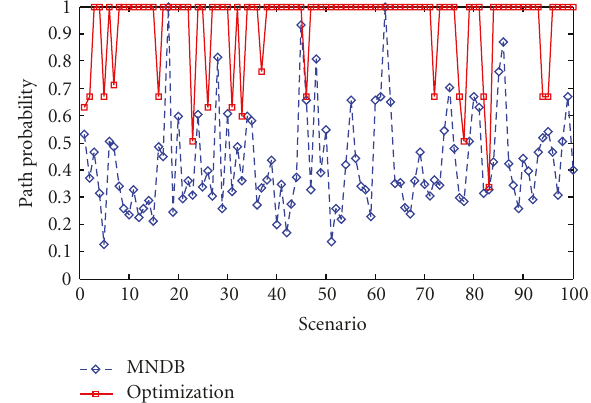
Figure 6: Path probability optimization for 2-connected network.